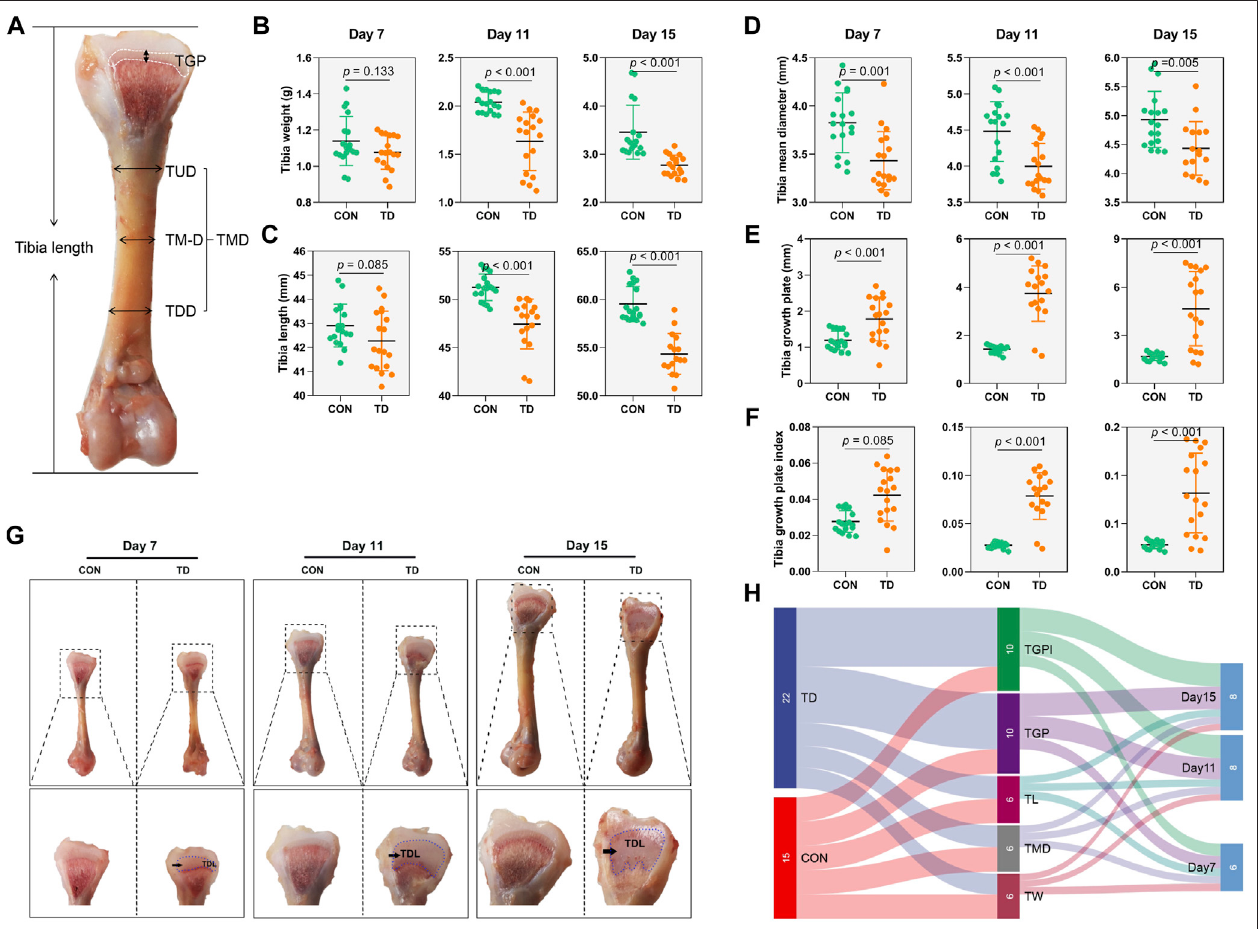
FIGURE 1 | Tibia related-parameters of broiler chickens. (A) Standard for the measurement of tibia length, TUD (Upper 1/2 diameter of the tibia), TMD (tibia mid- diameter), and TLD (Lower 1/2 diameter of the tibia). TMD (tibia mean diameter) comes from the average of the TUD, TMD, and TLD. (B – F) The tibia weight, tibia length, tibiameandiameter(TMD),tibiagrowthplate,andtibia growthplateindexwererecordedandcompared betweentheCONand TDgroupsfrom7-,11-,and15-day-old broiler chickens. A statistical difference of p-value less than 0.05; data represent means ± SD, two-tailed unpaired Student ’ s t-test. N = 18. (G) Morphological observation of the tibial growth plate in the CON and TD groups from 7-, 11-, and 15-day-old broiler chickens. The black arrows indicate TD lesion. (H) Sankey diagram depicting tibia related-parameters by test point in the CON and TD groups of broiler chickens.